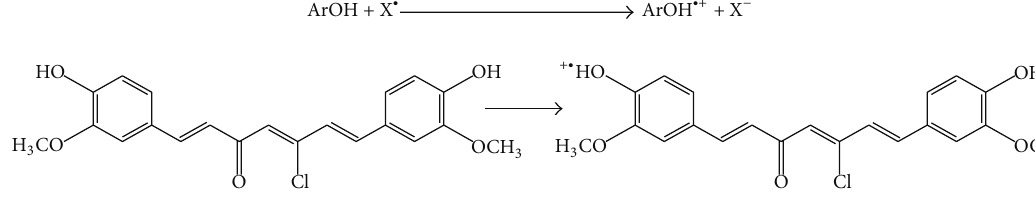
Scheme 2: Single electron transfer mechanism.